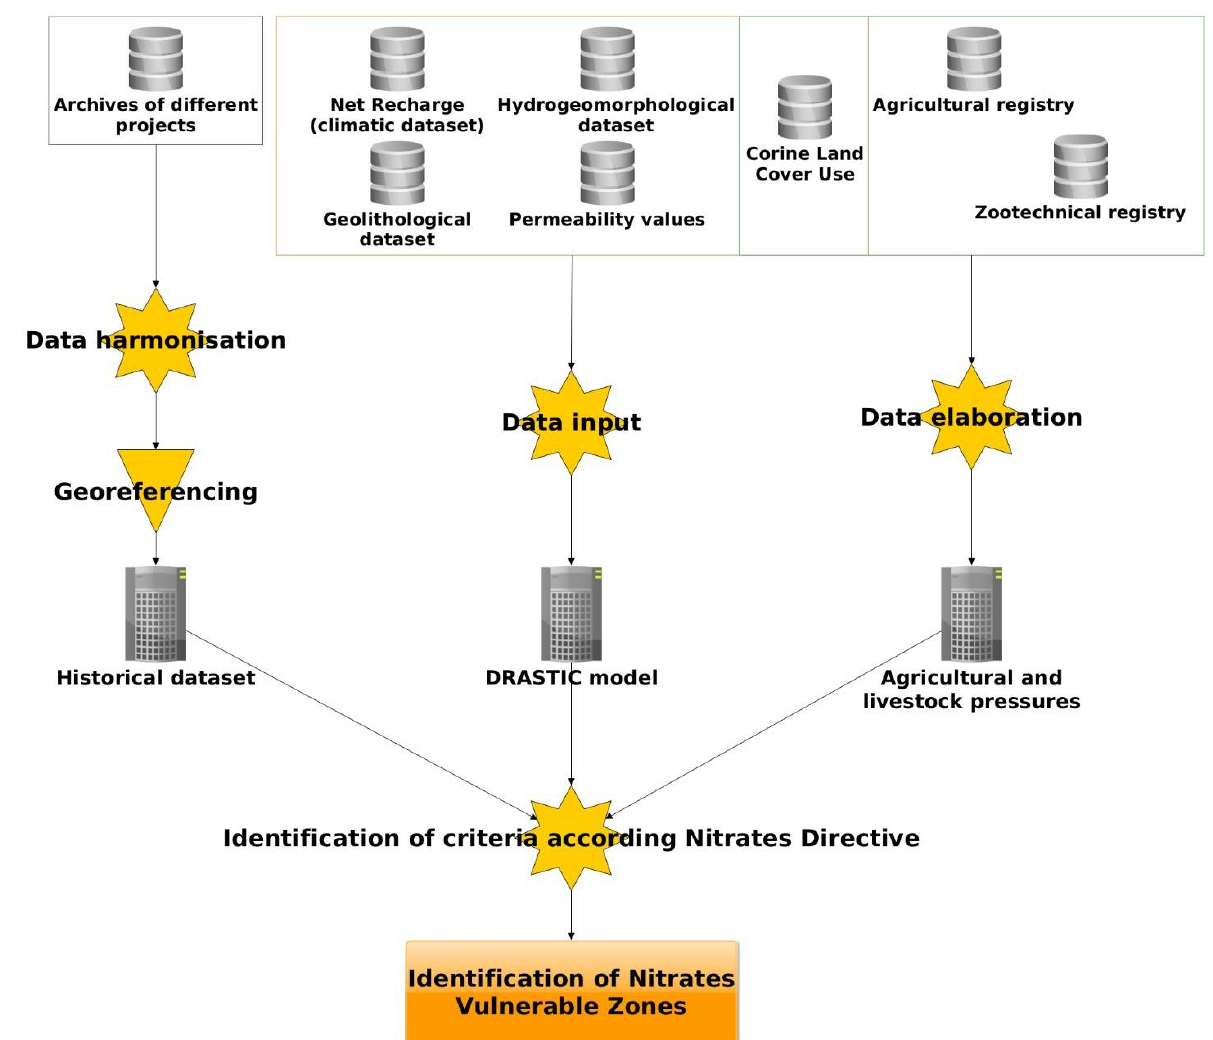
Figure 1. Operational workflow adopted.